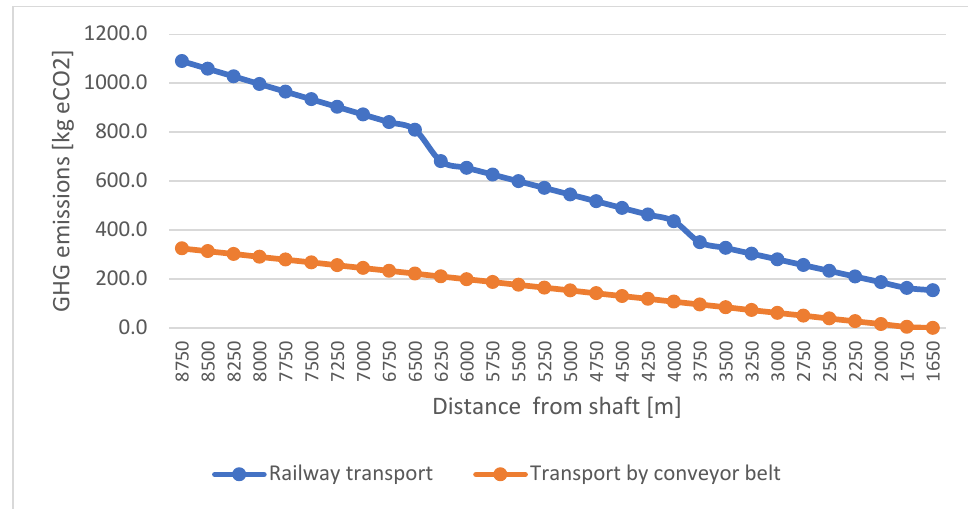
Figure 5. GHG emission value for the daily crew transport cycle using conveyor belts and suspended rail rolling stock.